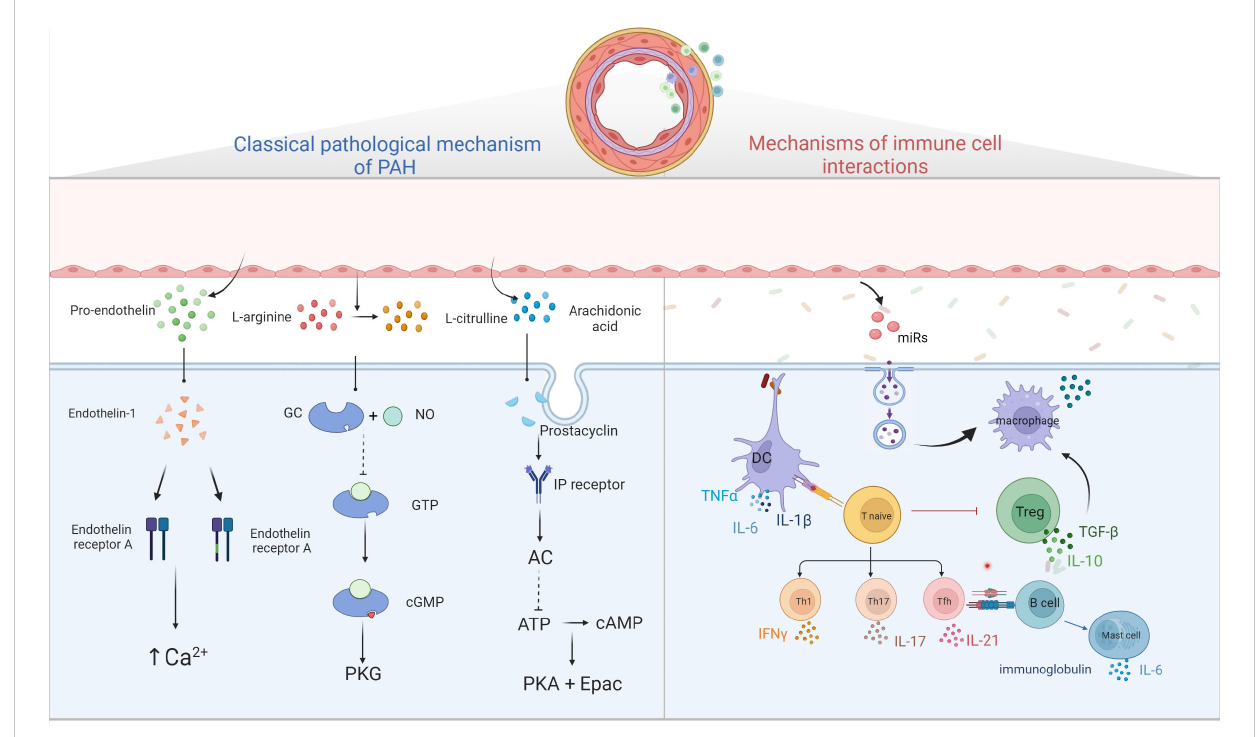
FIGURE 2 Diagram of PAH pathological mechanism. Three classical pathways; ET-1 binds to ETA and ETB receptors to promote intracellular Ca 2+ release and Ca 2+ channel opening, leading to increased intracellular Ca 2+ and vascular remodeling; prostacyclin binds to GPCR and IP receptors, activating adenylate cyclase, converting ATP to cAMP and inhibiting cell proliferation by activating PKA and Epac; NO binds to GC, converting GTP to cGMP, thereby activating downstream PKG and causing vascular diastole. Immune cells and pulmonary hypertension, DCs stimulate T cell activation, T cells participate in pulmonary vascular remodeling by producing IL, TNF- a , IFN- g , B cells participate in pulmonary vascular remodeling by over-secreting antibodies, cytokines, etc. Mast cells participate in the development of PAH by producing large amounts of IL-6, while reducing IL-6 production or inhibiting mast cell activation can reduce B lymphocyte production and can alleviate PAH. EC damages will release microvesicles, which contain miRs, and others, these MVs will stimulate macrophages to secrete cytokine such as TGF- b , and then stimulate PASMC